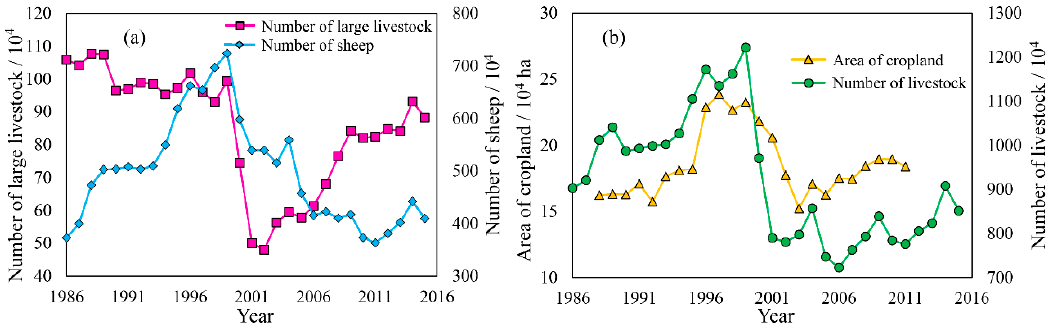
Figure A5. Population and gross national product (GDP) trends of OSL from 1985 to 2015.